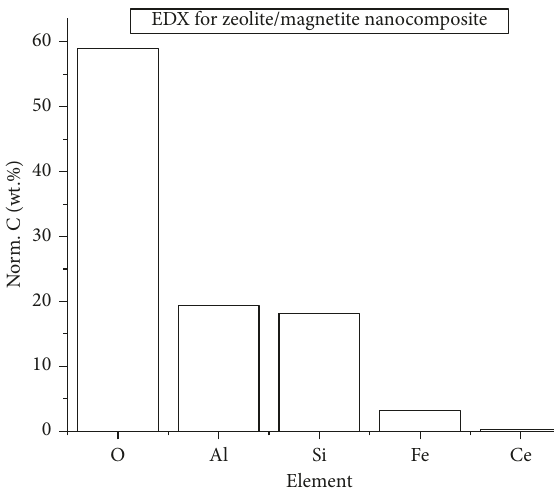
Figure 3: EDX of zeolite/magnetite